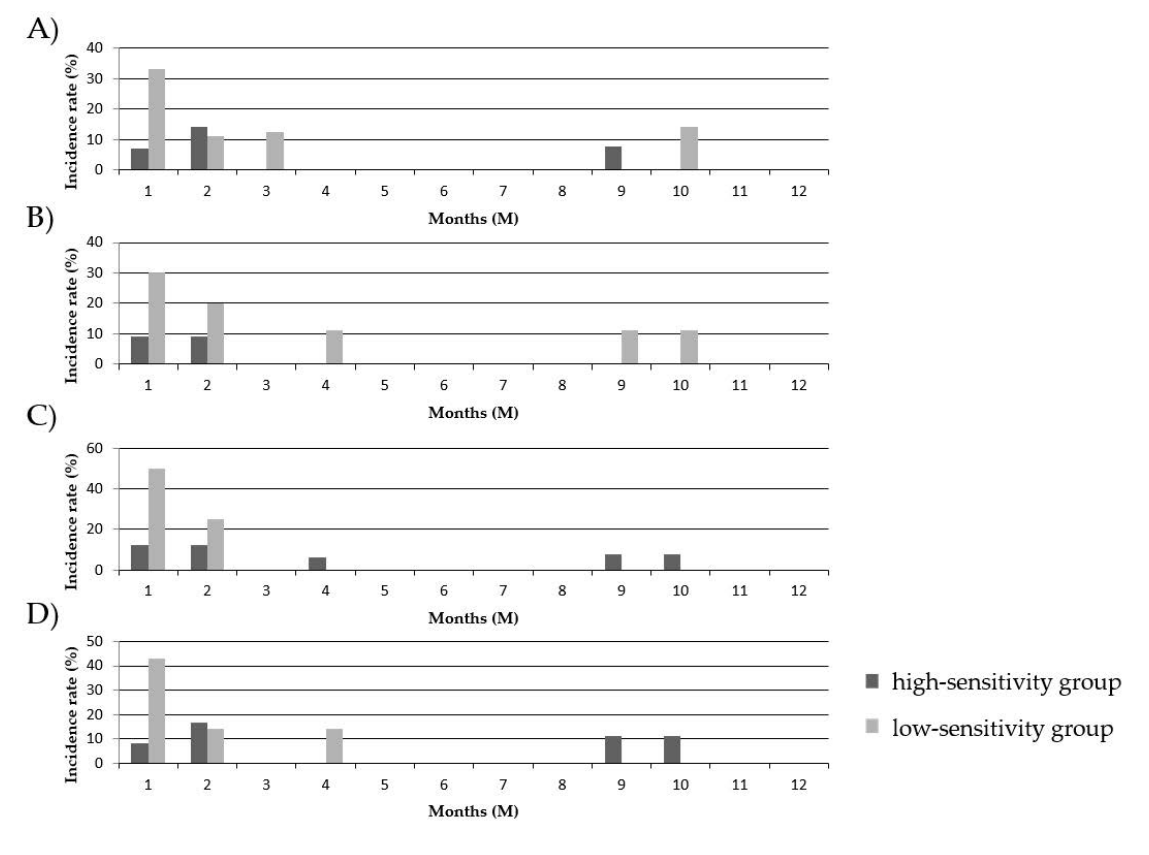
Figure 5. Comparison of the onset time of AR between the PBMC high-sensitivity group and the PBMC low-sensitivity group to GCs. The onset times of AR in the PBMC high-sensitivity group and the PBMC low-sensitivity group to COR before transplantation ( A ), MPSL before transplantation ( B ), COR after transplantation ( C ), and MPSL after transplantation ( D ) were